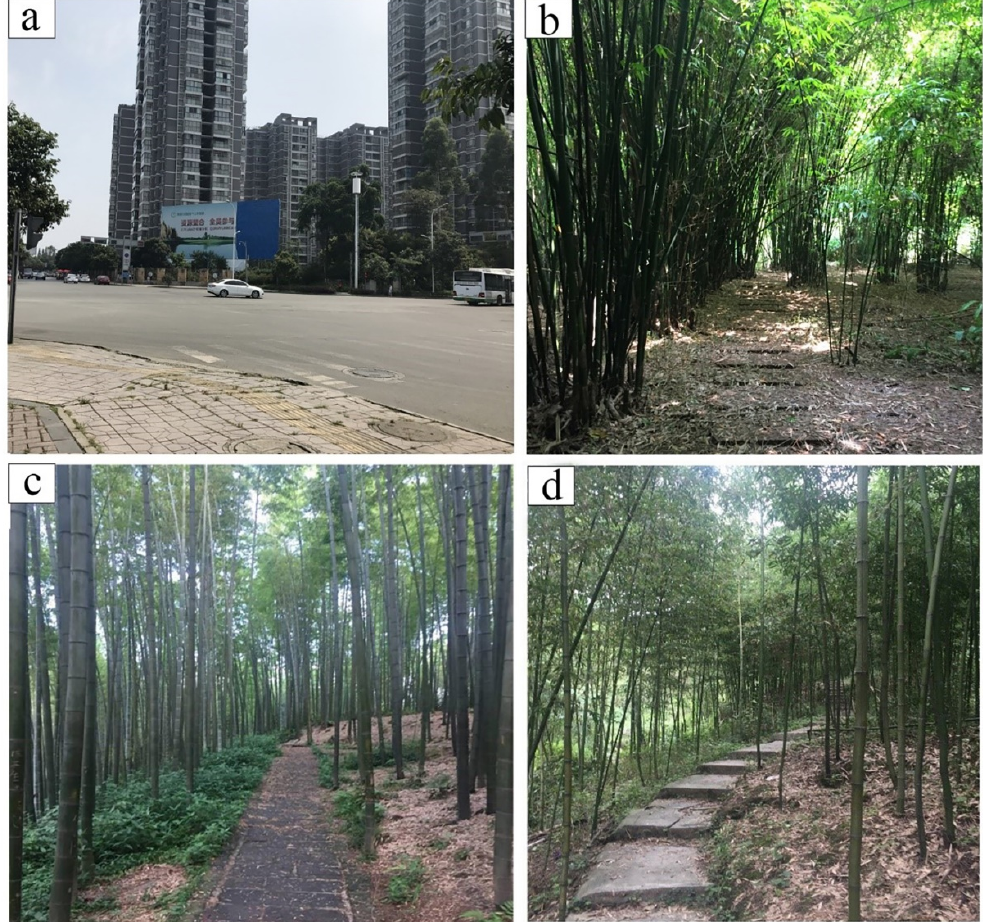
Figure 2. Photographs of the studied sites. ( a ) The CS site was located at a crossroad in a typical urban environment with cars, buildings, markets, hotels, and companies; ( b )–( d ) show the bamboo forest sites with path. ( b ) Neosinocalamus affinis bamboo forest; ( c ) Phyllostachys heterocycla bamboo forest; ( d ) P. praecox f. prevernalis bamboo forest. Table 1. Basic information of the sampling subjects at the four sites included in this study. CS Parameter